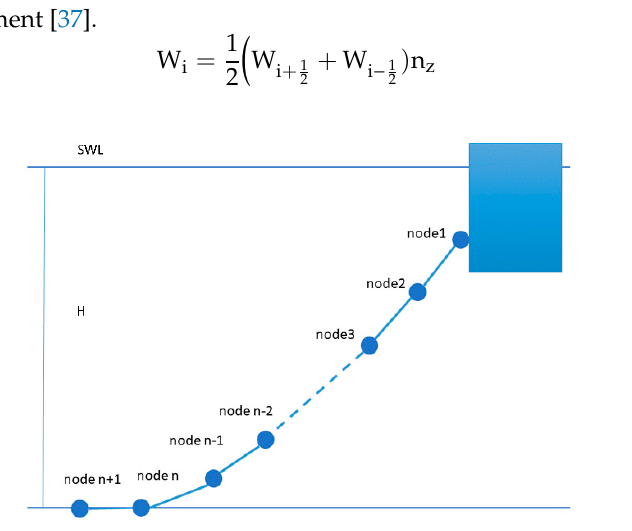
Figure 3. Lumped-mass and spring model.